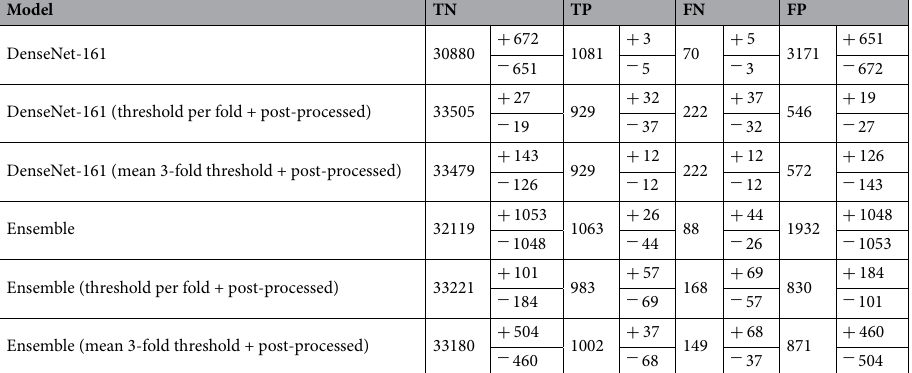
Table 3. 3-fold averaged confusion matrix value results after applying optimal thresholds and the single tile removal post-processing to the DenseNet-161 and ensemble models, for the hold-out test sets. Presented in this table are the true negative (TN), true positive (TP), false negative (FN) and false positive (FP) values averaged across all three folds, rounded to the nearest whole figure. Plus/minus values shows the mean subtracted from the highest and lowest results from the 3-fold experiments, for each